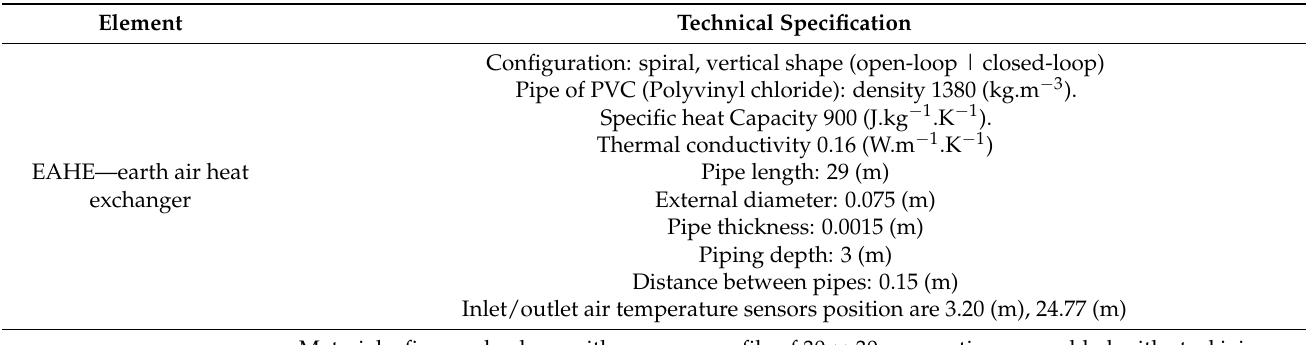
Table 1. Main characteristics and technical specifications of the equipment used in the experimental setup. Technical